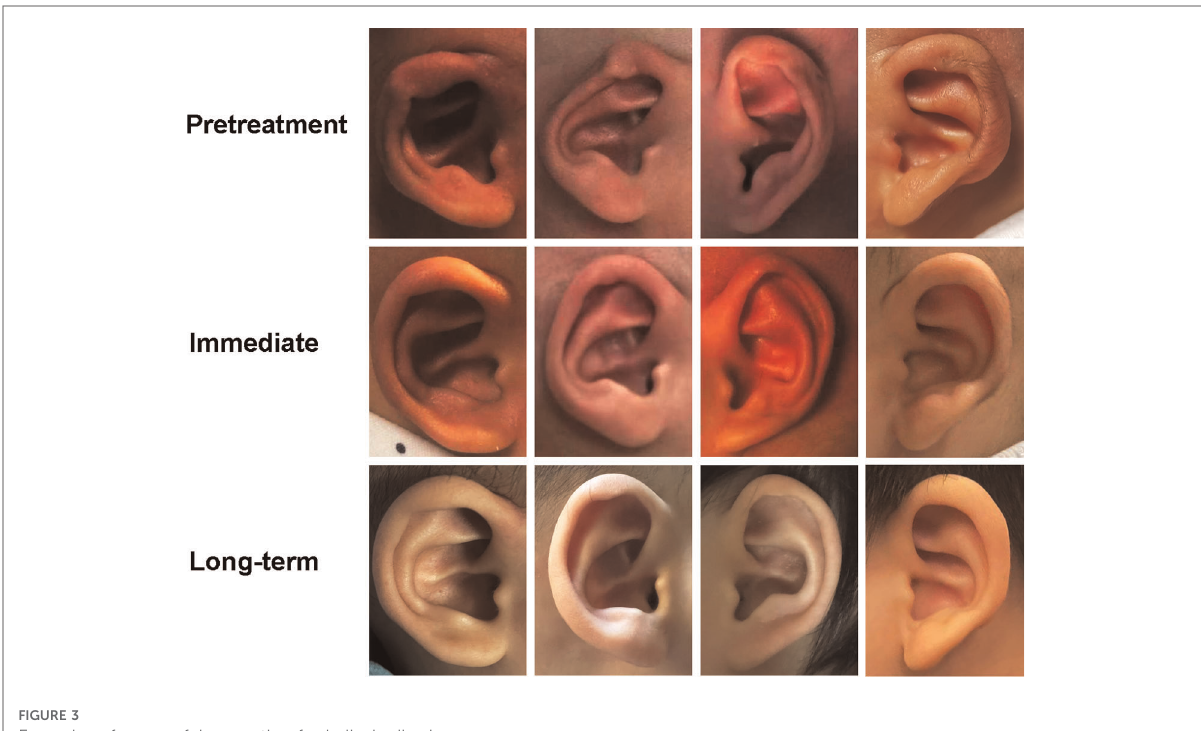
FIGURE 3 Examples of successful correction for helical adhesion.